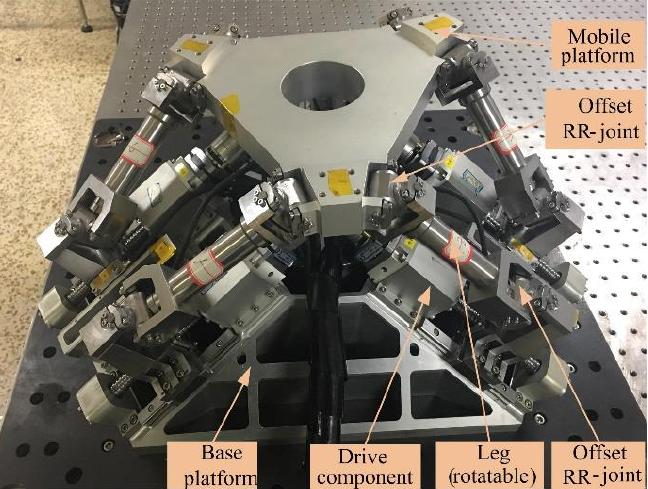
Figure 1. Configuration and structural components of the parallel platform.